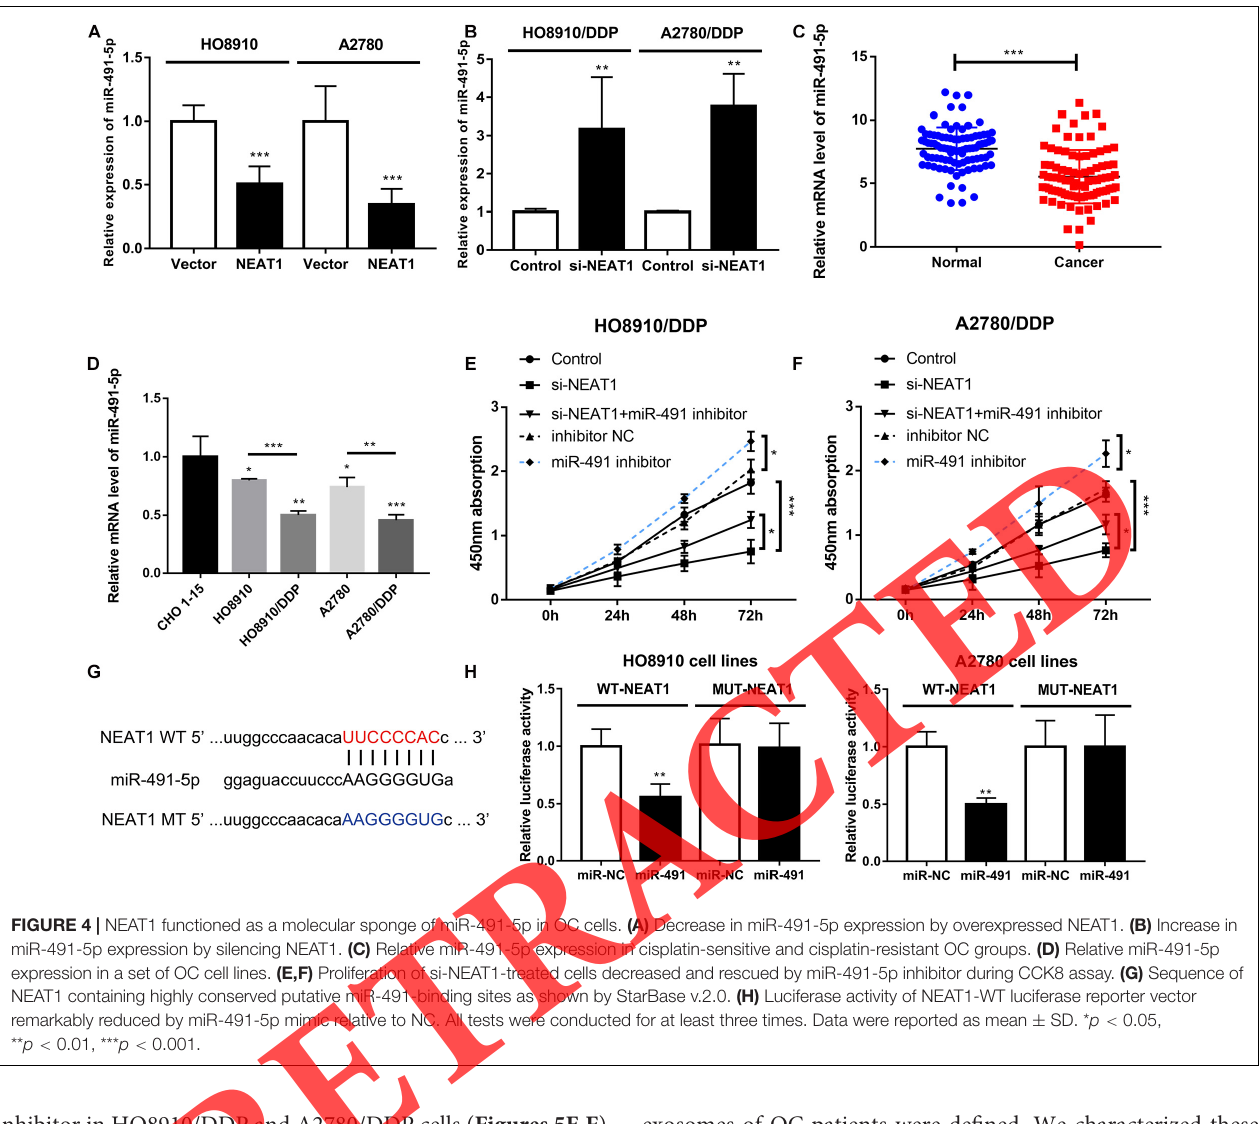
inhibitor in HO8910/DDP and A2780/DDP cells ( Figures 5E,F